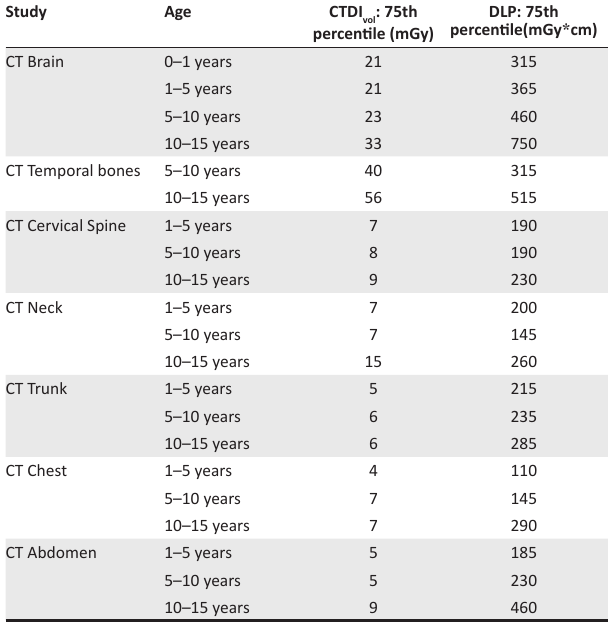
TABLE 9: Proposed local diagnostic reference levels for Computed Tomography Dose Index and Dose Length Product for paediatric computed tomography volume